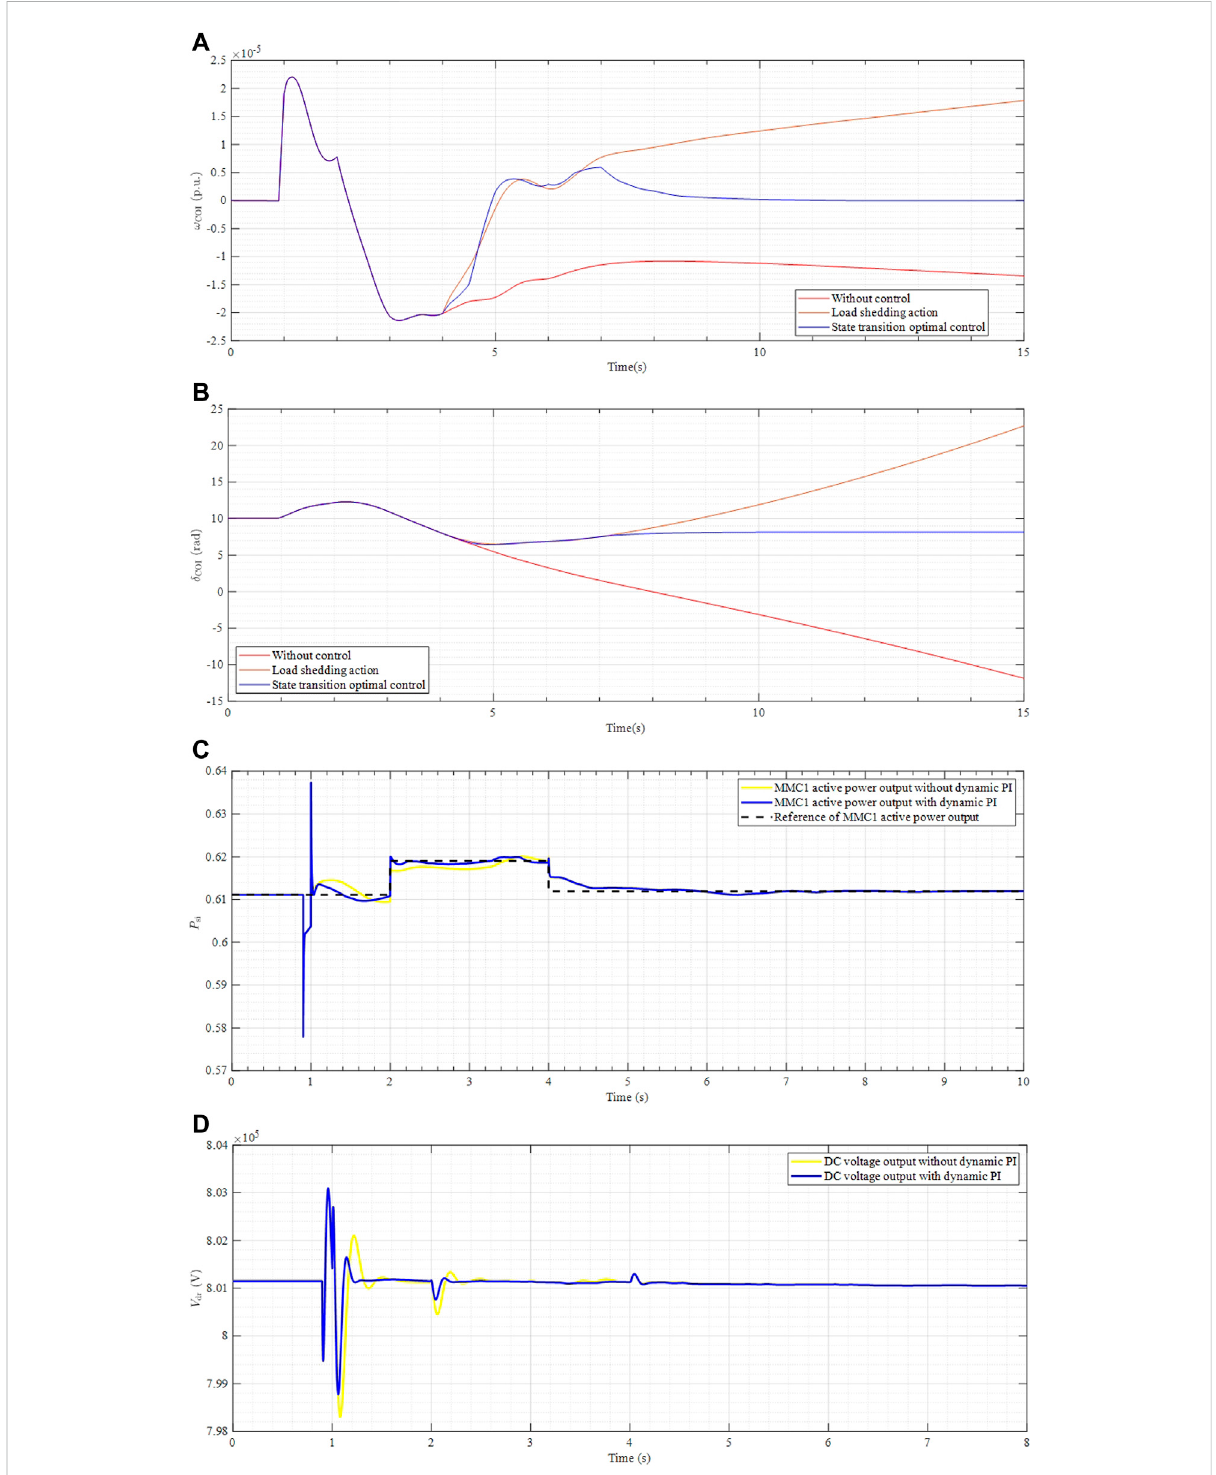
FIGURE 7 Dynamicofthe10-machine39-bussysteminthecasewhenN-3contingencyoccurs. (A) Anglespeedofthecenterofinertia. (B) Rotorangleof the center of inertia. (C) Active power output of the inverter-side MMC. (D) DC voltage output of the recti fi er-side